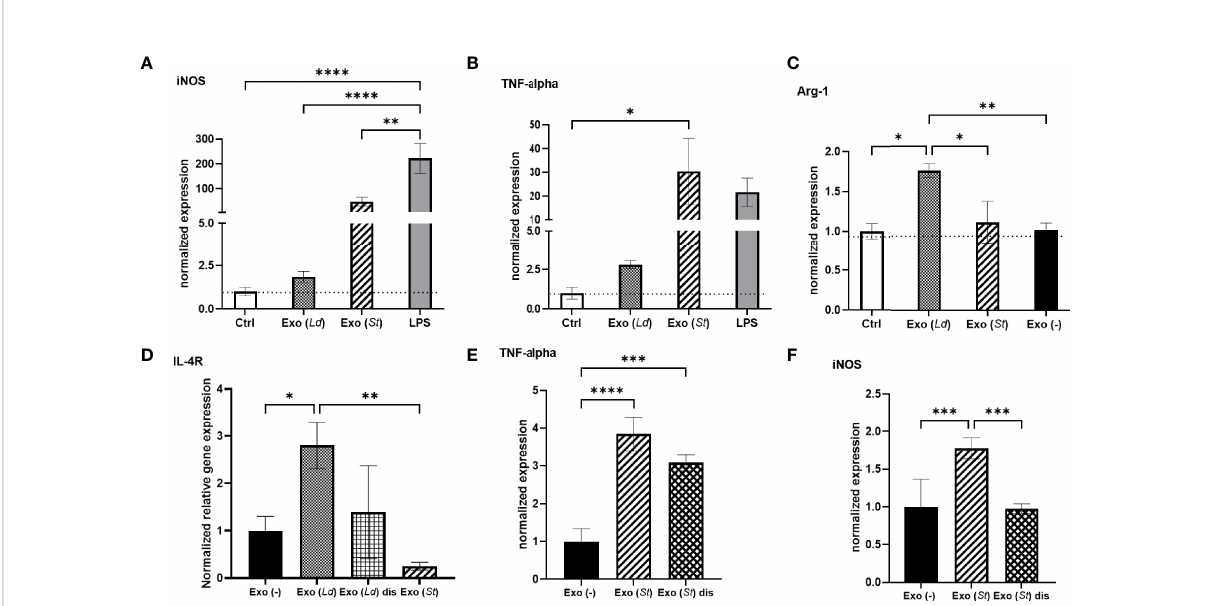
FIGURE 6 The effect of EVs derived from L. donovani -infected macrophages on macrophage polarization. RAW 264.7 macrophages were infected with L. donovani (72 hpi) or S. Typhimurium (MOI 5:1, 24 hpi). The EVs obtained from these cells were used to treat primary macrophages for 24 hours. Media (Ctrl) or EVs from uninfected cells were used as negative controls, and LPS treatment 100 ng/mL was used as a control treatment. The cells were collected and RNA puri fi ed for RT-qPCR analysis of iNOS (A, F) , TNFa (B, E) , Arg1 (C) , and IL-4R (D) . One-way ANOVA for multiple comparison tests was used to establish statistical signi fi cance. N=6. Exo (-), EVs from uninfected cells; Exo ( Ld ), EVs from cells infected with L. donovani; Exo ( St ), EVs from cells infected with S. Typhimurium; Exo ( St ) dis, disrupted EVs from cells infected with S. Typhimurium, Ctrl, cells not treated. *P ≤ 0.05; **P ≤ 0.01; ***P ≤ 0.001; ****P ≤